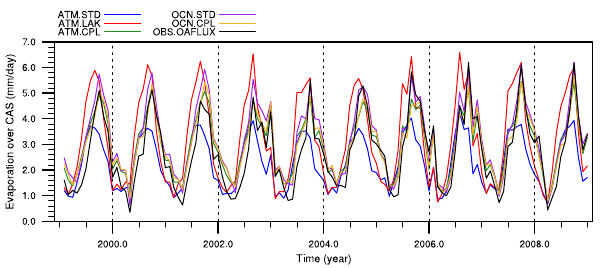
Fig. 15. Time series of monthly Caspian Sea Level (CSL) varia- tion (m) of modeled (ATM.STD, ATM.LAK and ATM.CPL) and observed (altimetry data from GRLM project) for the period 1995– 2008. The dashed lines represent the 3-yr running averages to show the inter-annual